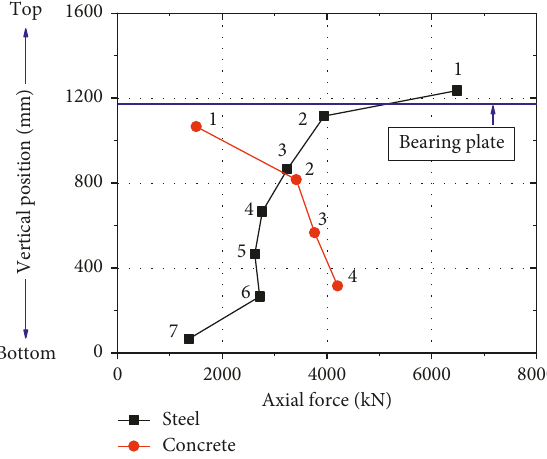
Figure 12: Distribution of axial force along the vertical direction shared by the steel and concrete